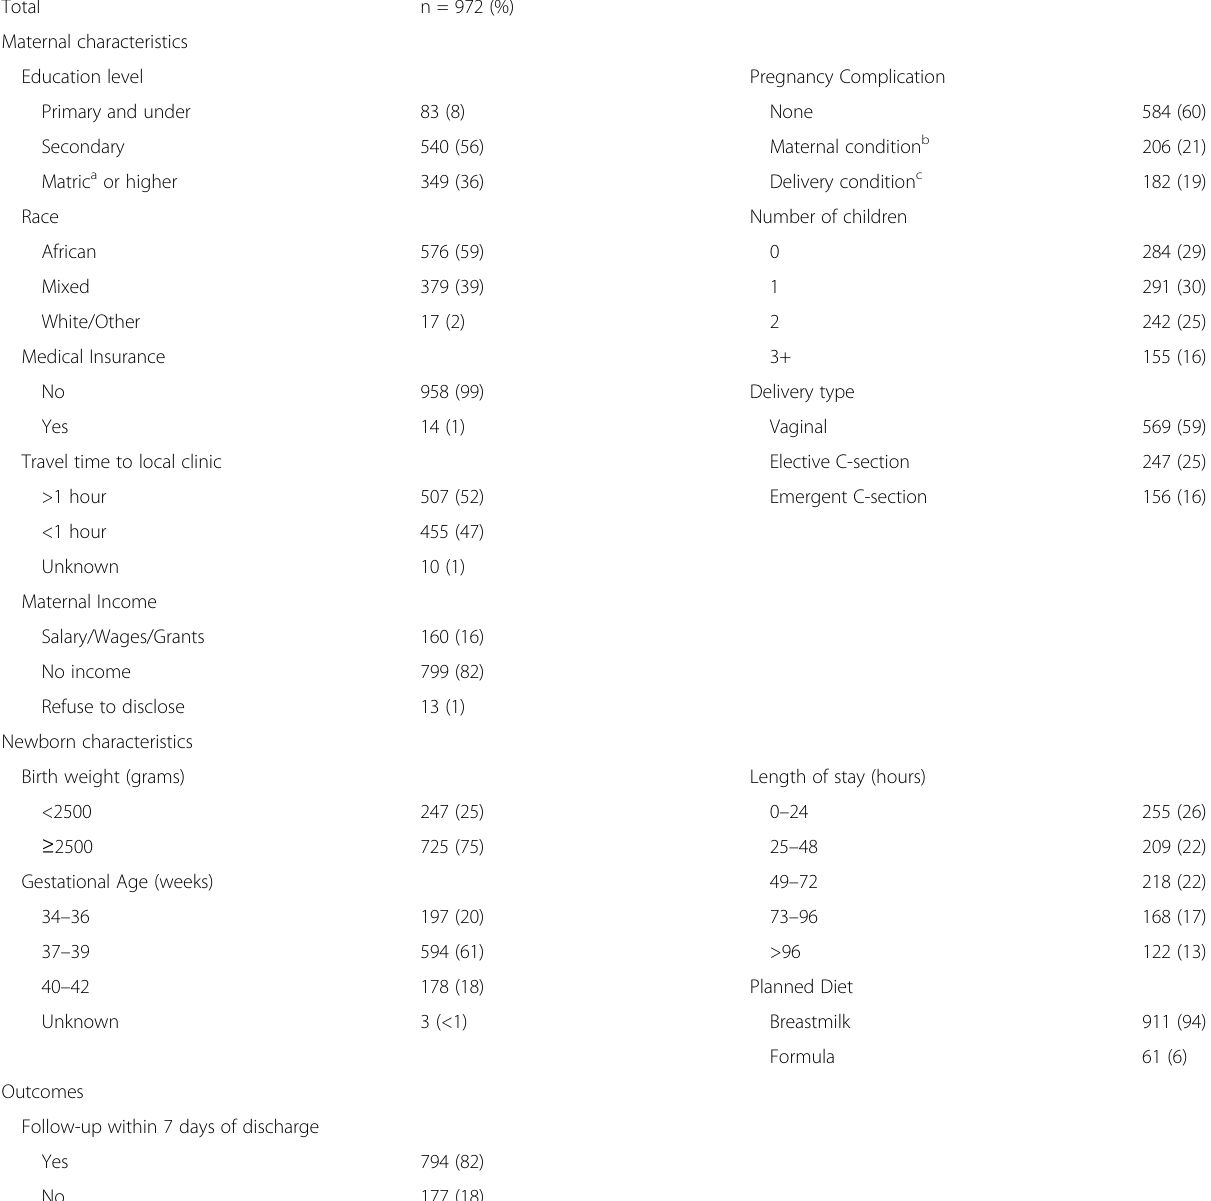
Table 1 Maternal and newborn